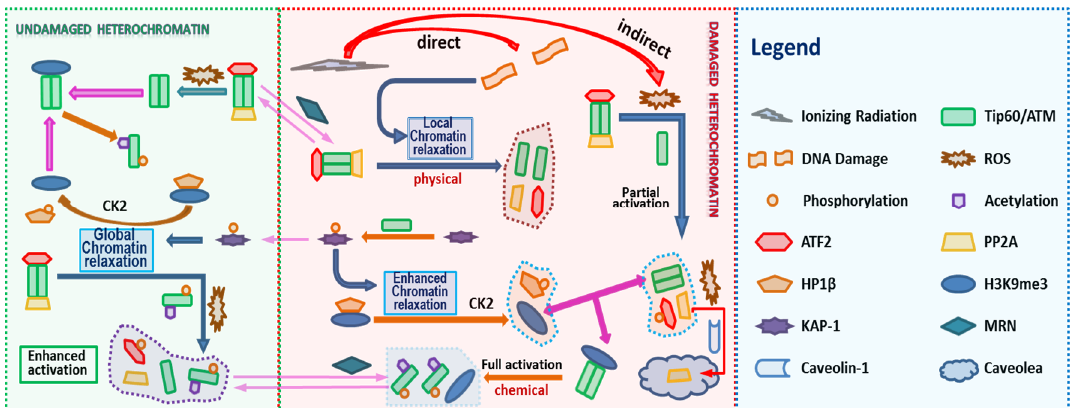
Figure 3. Biochemical Reactions in the ATM Activation. ATM activation consists in a series of biochemical reactions, protein binding / unbinding, including phosphorylation / dephosphorylation, acetylation / deacetylation. The Figure 2 Legend lists names of molecules considered in the reaction pathway. In addition, the shuttling of molecules between the DNA damaged site and undamaged site can be written in terms of appropriate reactions (See Supplementary Material).